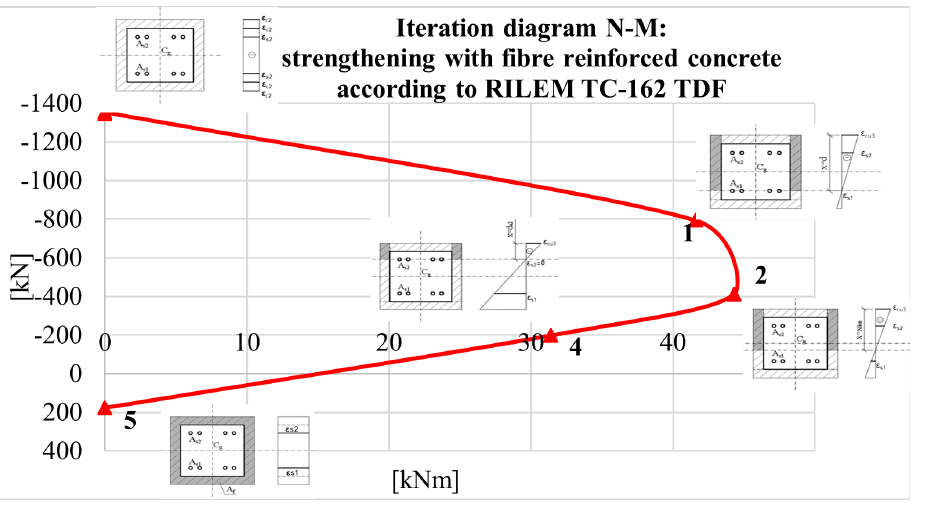
Figure 5. Iteration diagram - point